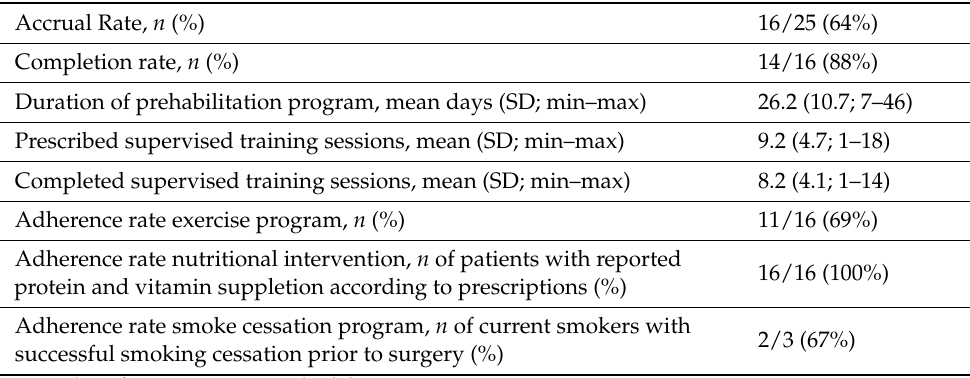
Table 2. Feasibility